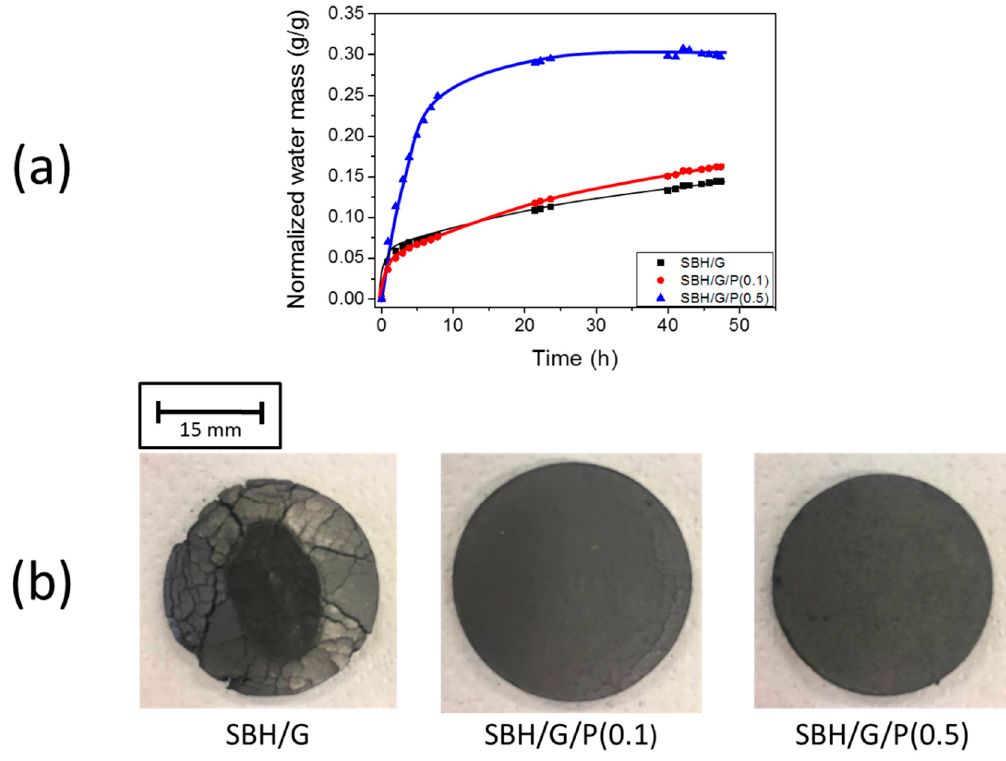
Figure 6. ( a ) Hydration test on composites tabs; ( b ) pictures of the tabs after one dehydration/hydration